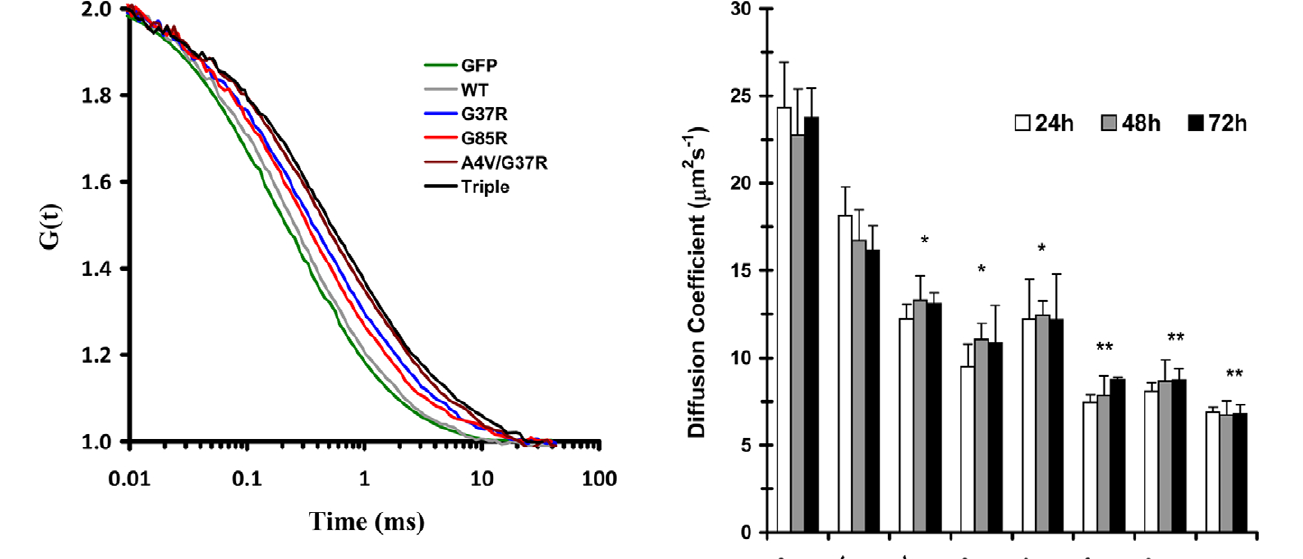
Figure 5. Diffusional mobility of wild-type SOD1 and SOD1 mutants in MN-1 cells. The autocorrelation curves for GFP, wild-type SOD1, and SOD1 mutants were measured 72h after transfection. Curves were normalized using the Confocor2 program.